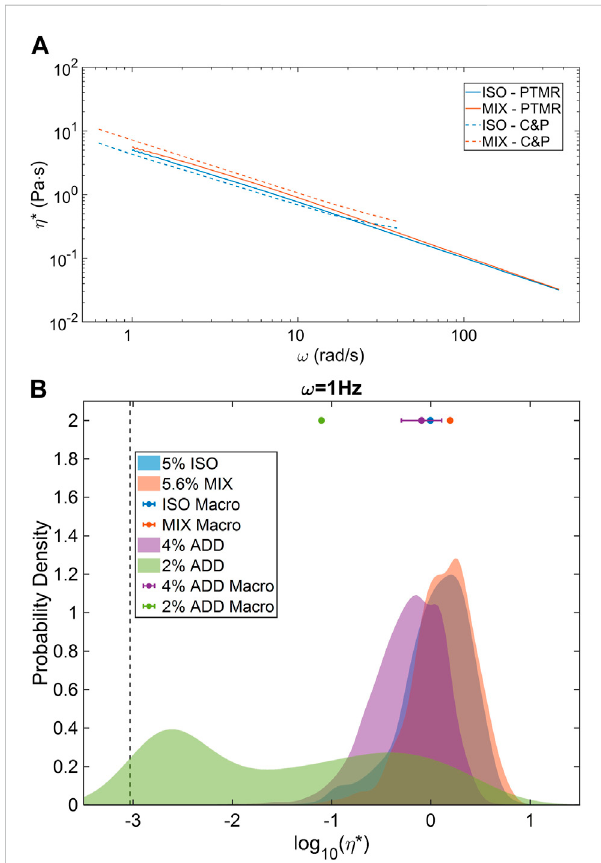
FIGURE 4 Macro and microrheological comparison of ETT mucus rheology. (A) ISO and MIX pools demonstrated strong agreement in complex viscosity across nearly two decades of frequency response. (B) Higher % solids samples displayed homogeneous PTMR distributions while 2% ETTdisplayed abimodal, low and high-viscosity behavior. However, central tendencies of all distributions were in agreement with mean bulk rheological behavior. Data obtained from n = 3 technical